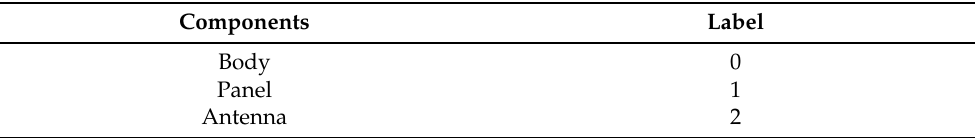
Figure 7. Screenshot of annotation system. Table 2. Label of components in 3D spacecraft component segmentation dataset.